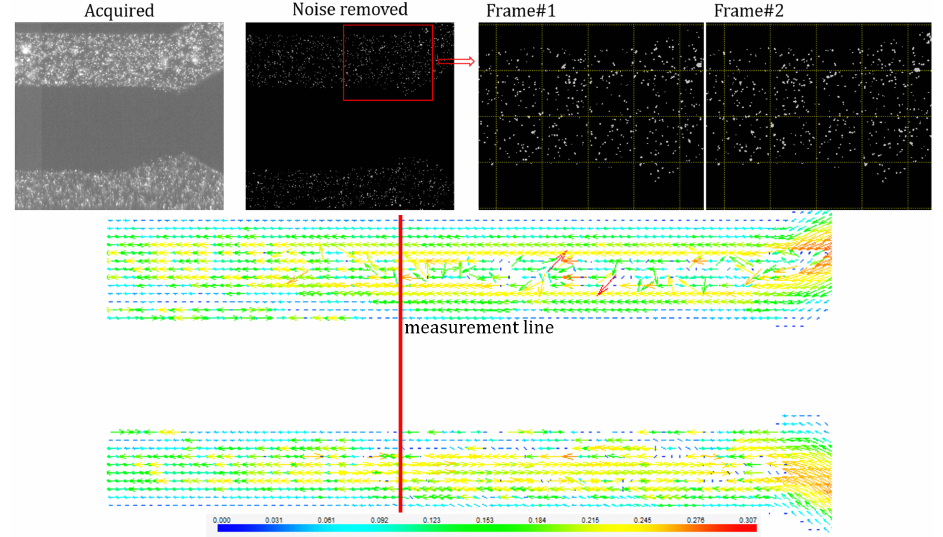
Figure 16. Micro-PIV measurement—image acquisition and processing, vector map in the aque- ous